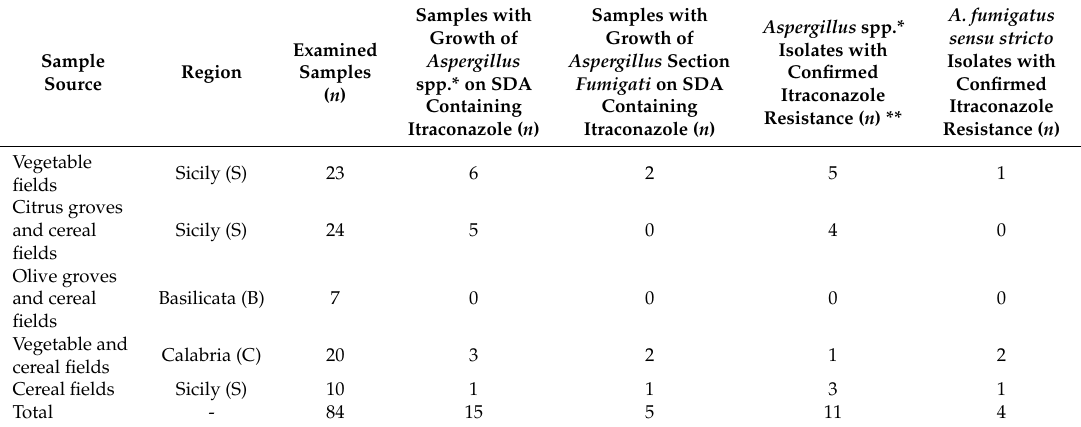
Table 1. Environmental origin of itraconazole-resistant Aspergillus spp. and Aspergillus section Fumigati isolates.